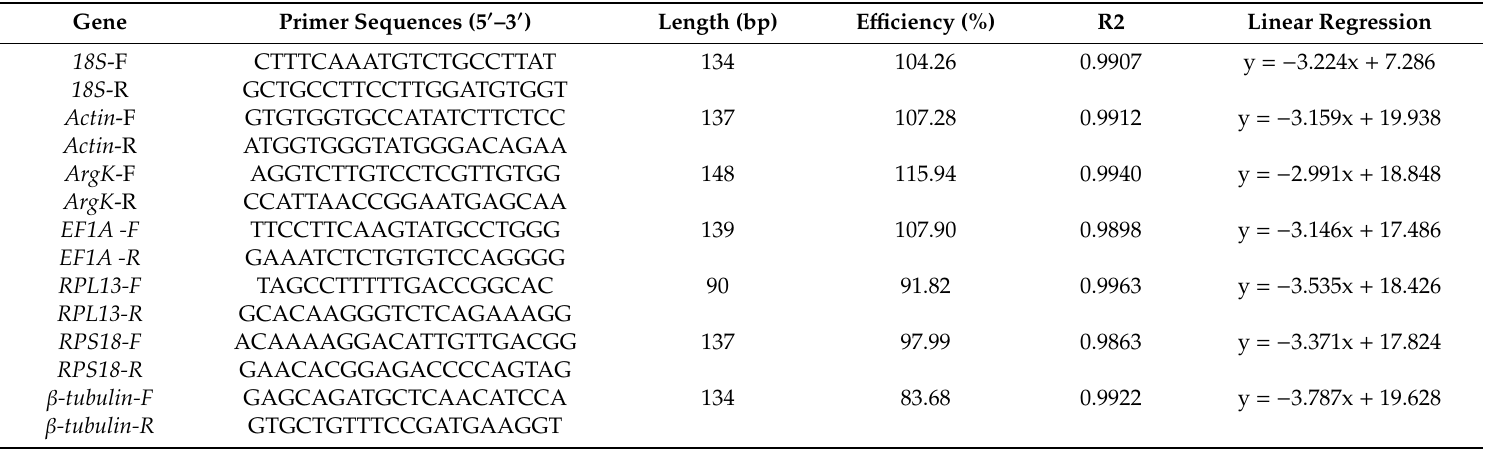
Table 1. Reference genes used in this